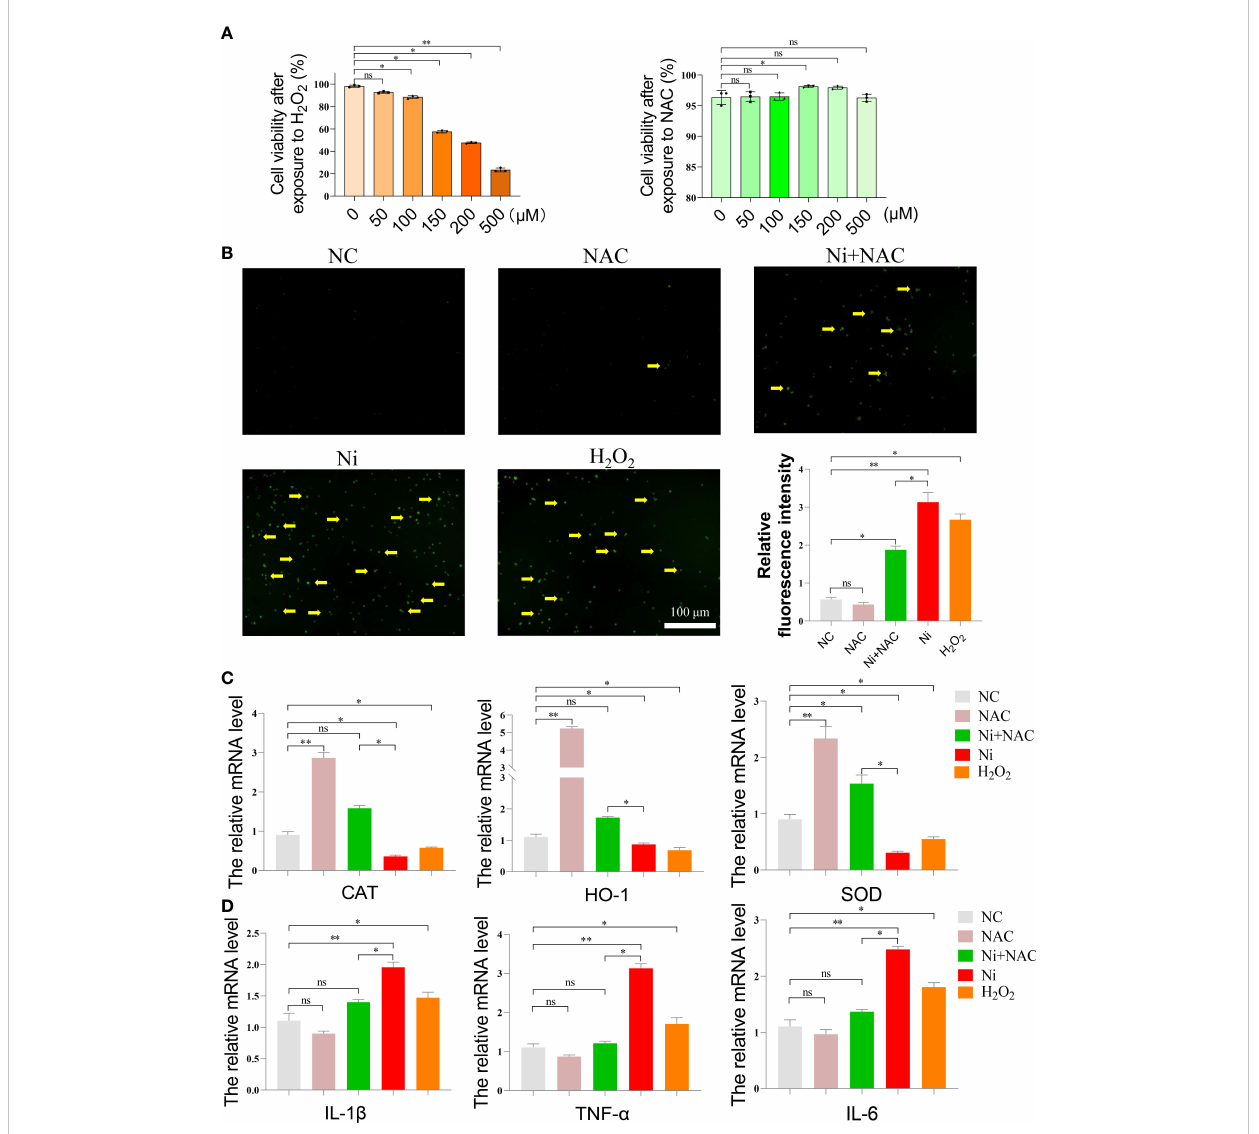
FIGURE 5 (A) Cell survival rate of spleen lymphocytes exposed to different concentrations of N-acetyl-L-cysteine (NAC) and hydrogen peroxide (H ROS staining of spleen lymphocytes exposed to NiCl 2 , H 2 O 2 and NAC. The green dot pointed by the yellow arrow represents the ROS level. ImageJ analyzes the average fl uorescence intensity of ROS staining in each group. ns represents no statistical difference between the two groups, * represents signi fi cant difference between the two groups (P<0.05), and ** represents extremely signi fi cant difference between the two groups (P<0.01). (C) mRNA expression of antioxidant enzyme-related genes after spleen lymphocytes exposed to NiCl 2 , H 2 O 2 and NAC. (D) mRNA expression of in fl ammatory-related genes after spleen lymphocytes exposed to NiCl 2 , H 2 O 2 and